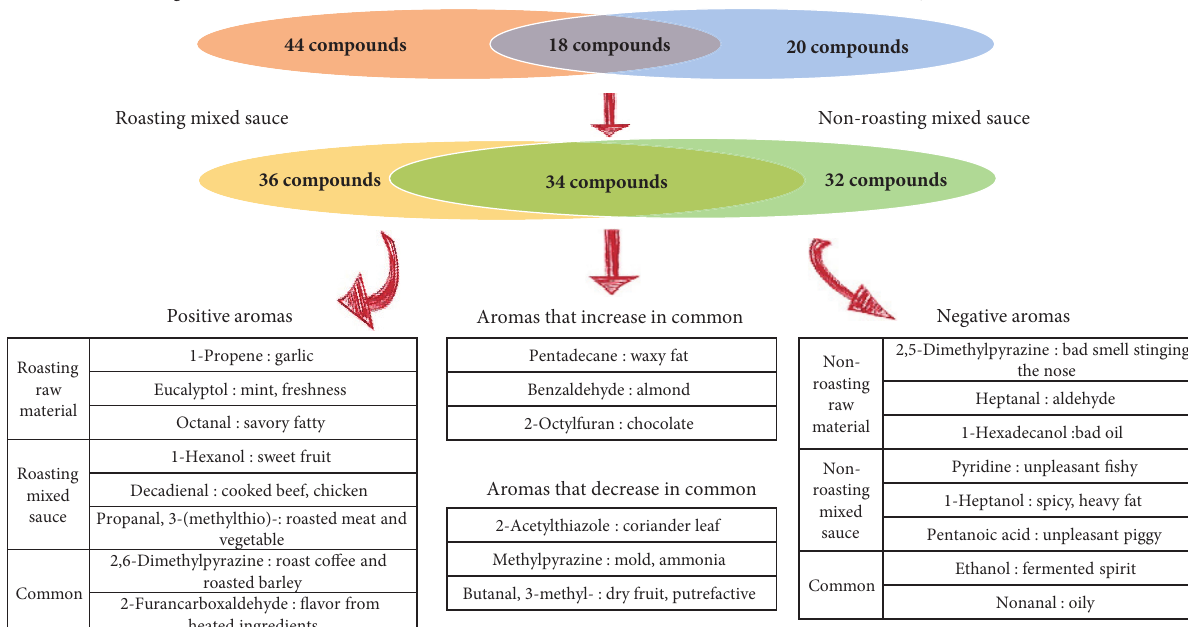
Figure 3: Composition of aroma components of raw material and mixed sauce according to roasting or nonroasting condition.